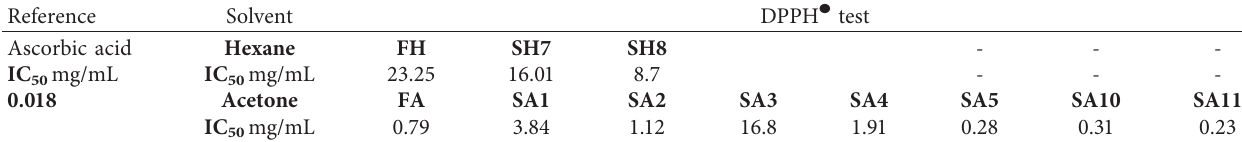
Table 8: Antioxidant activity of DPPH for hexane and acetone mother extracts and their fractions.